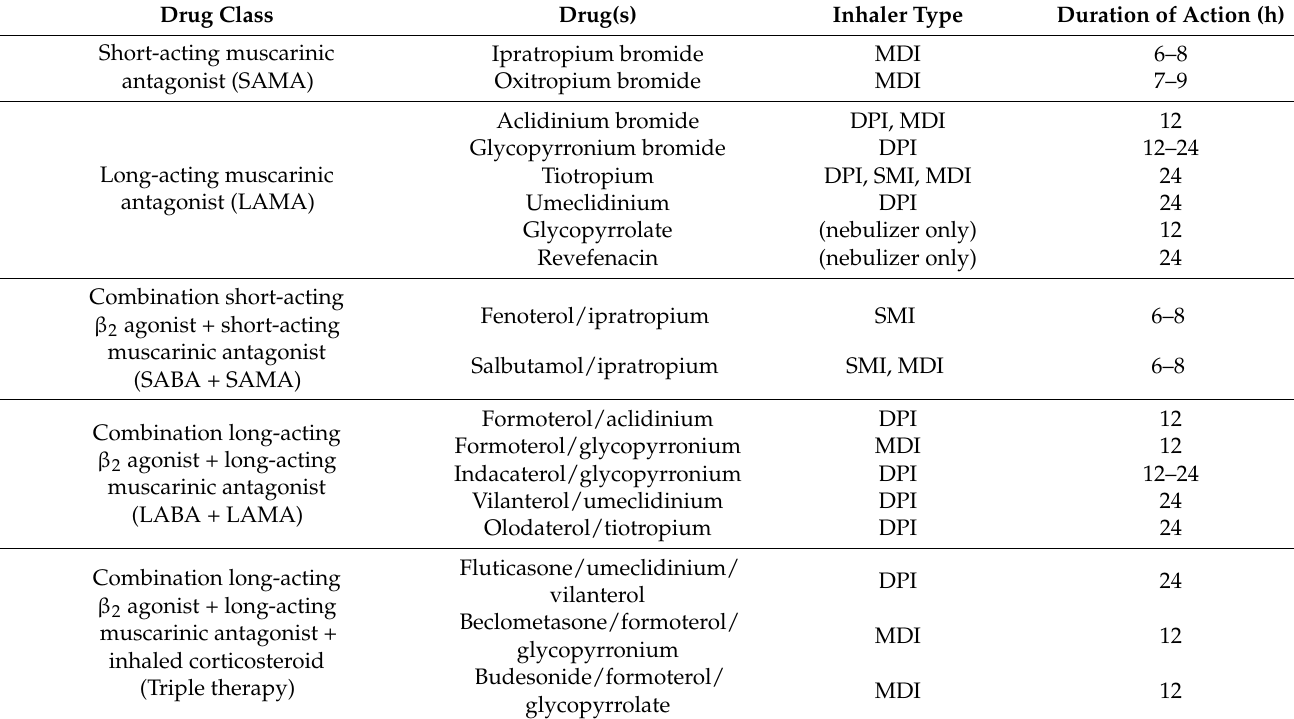
Figure 2. Recommendations for initial bronchodilator therapy from the 2023 Global Initiative for Chronic Obstructive Lung Disease. Adapted from GOLD 2023 [1]. CAT, COPD Assessment Test; GOLD, Global Initiative for Chronic Obstructive Lung Disease; LABA, long-acting β 2 agonist; LAMA, long-acting muscarinic antagonist; mMRC, modified Medical Research Council dyspnea questionnaire. Table 1. Short- and Long-Acting Bronchodilator Formulations That Contain Muscarinic An-Tagonists. Adapted from GOLD 2023 [1].